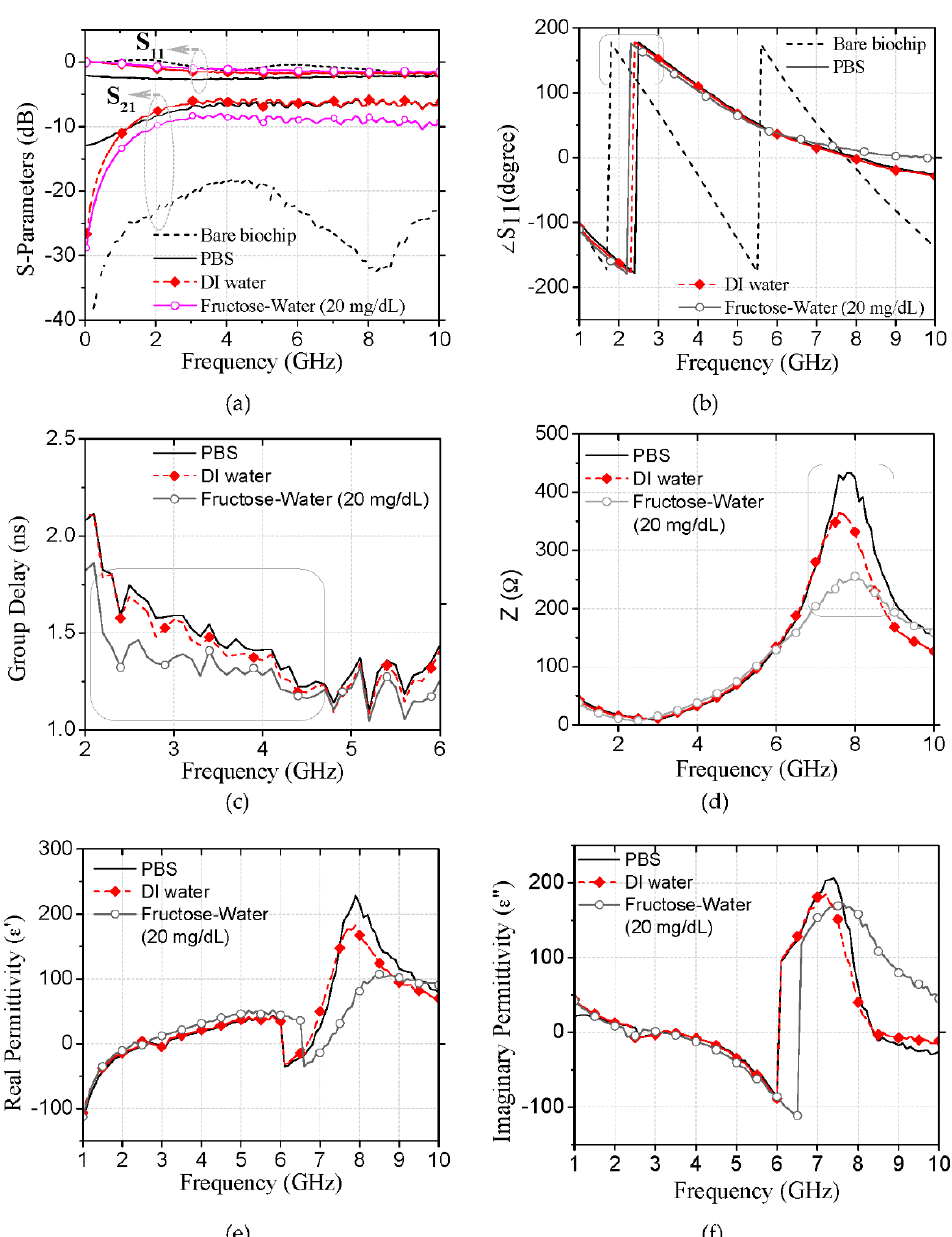
Figure 3. Microwave characterization of the proposed biochip for PBS, DI water, and the D -fructose-DI water solution. ( a ) S-parameters for the bare biochip and biochip bearing a 1-μL sample; ( b ) phase of S 11 ; ( c ) group delay; ( d ) self-resonating impedance; ( e ) real permittivity; ( f ) imaginary permittivity.